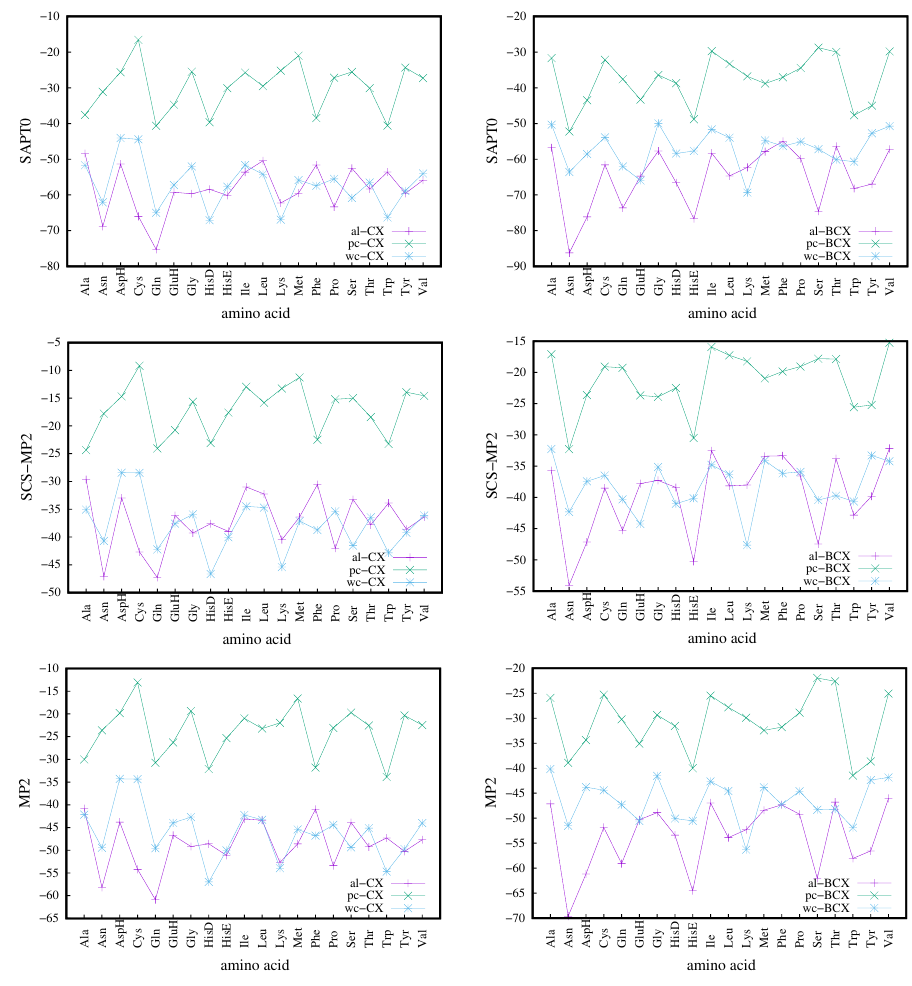
Figure 5. Trends in interaction energies for complexes with three conformers of calix[6]arene and hexa- p - tert -butylcalix[6]arene. Energies are in